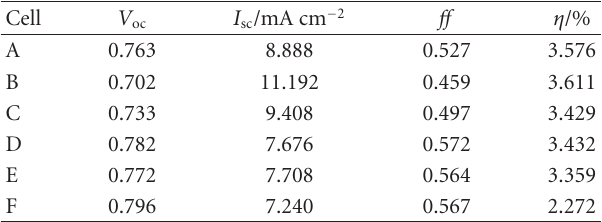
Table 3: Photovoltaic performances of DSSCs with PVDF/IL-SiO 2 (2/1)